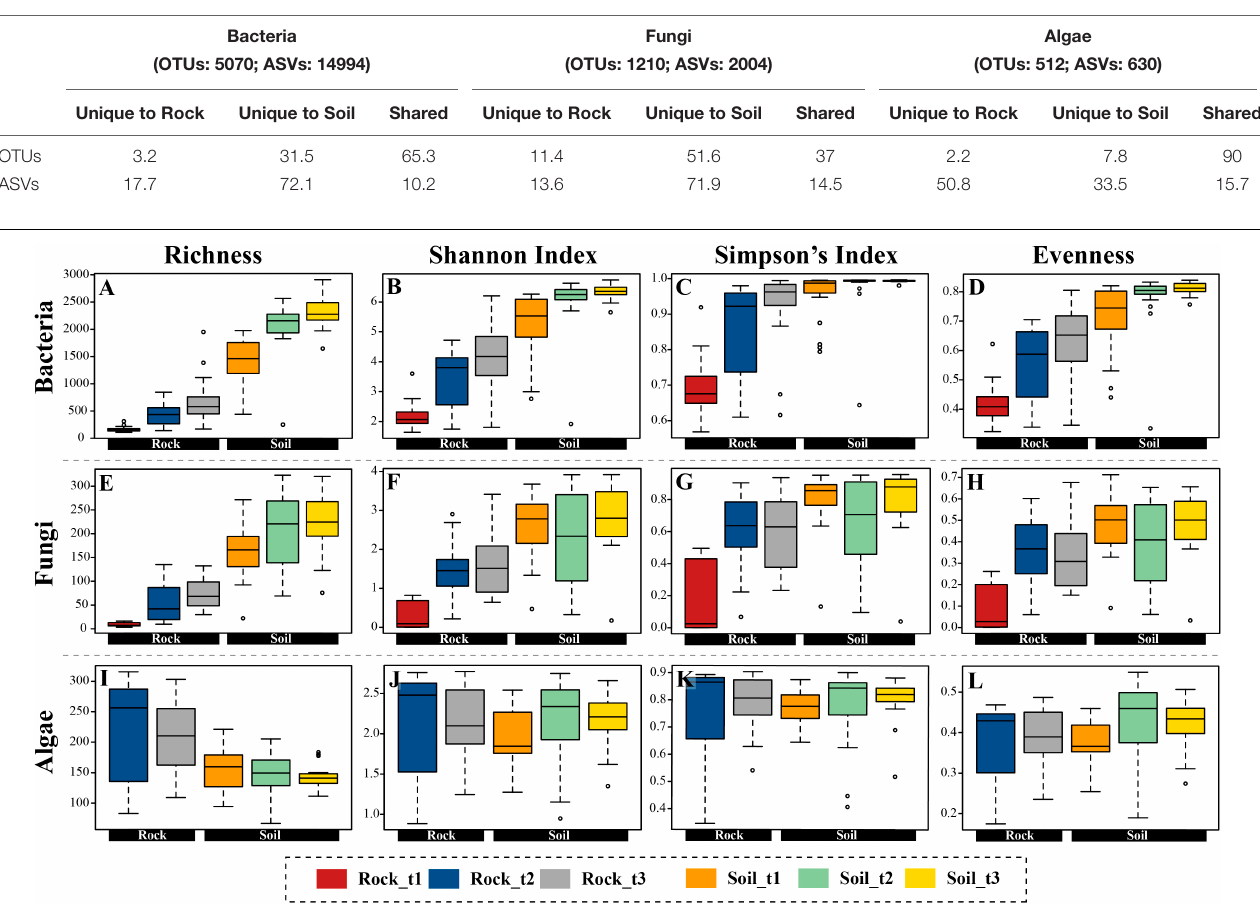
FIGURE 3 | Boxplots representing four alpha-diversity estimators (richness, Shannon and Simpson indices, and evenness) for bacteria (A–D) , fungi (E–H) , and algae (I–L) calculated with OTU data, and arranged according to substrate type (rocks, soil) and successional stage.